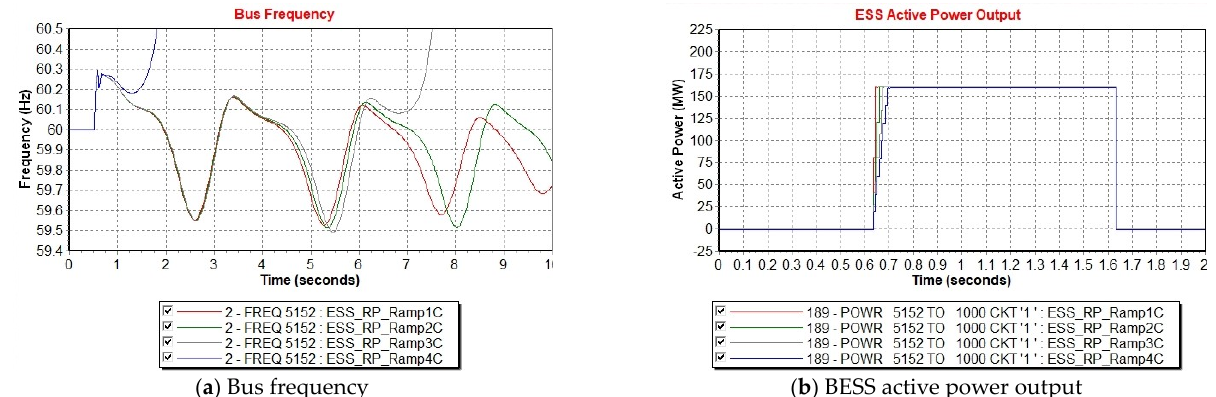
Figure 9. Performance of the constant charging strategy with different ramp-rates.